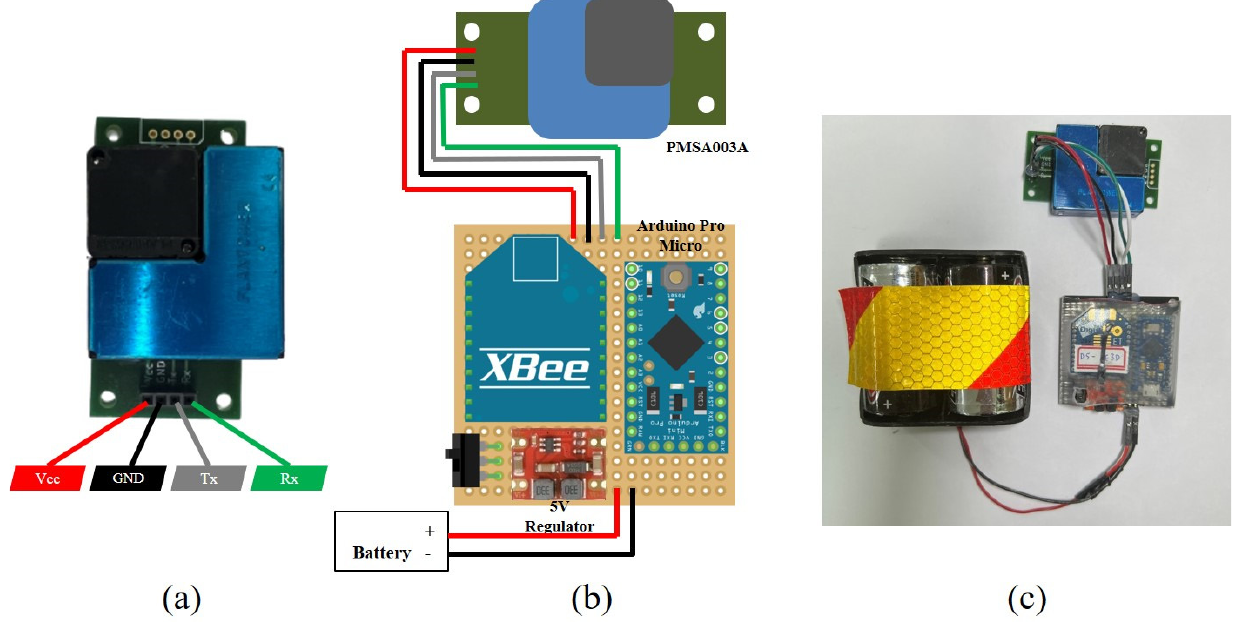
Figure 4. ( a ) PMSA003A dust sensor, ( b ) schematic, and ( c ) product of dust measurement module.